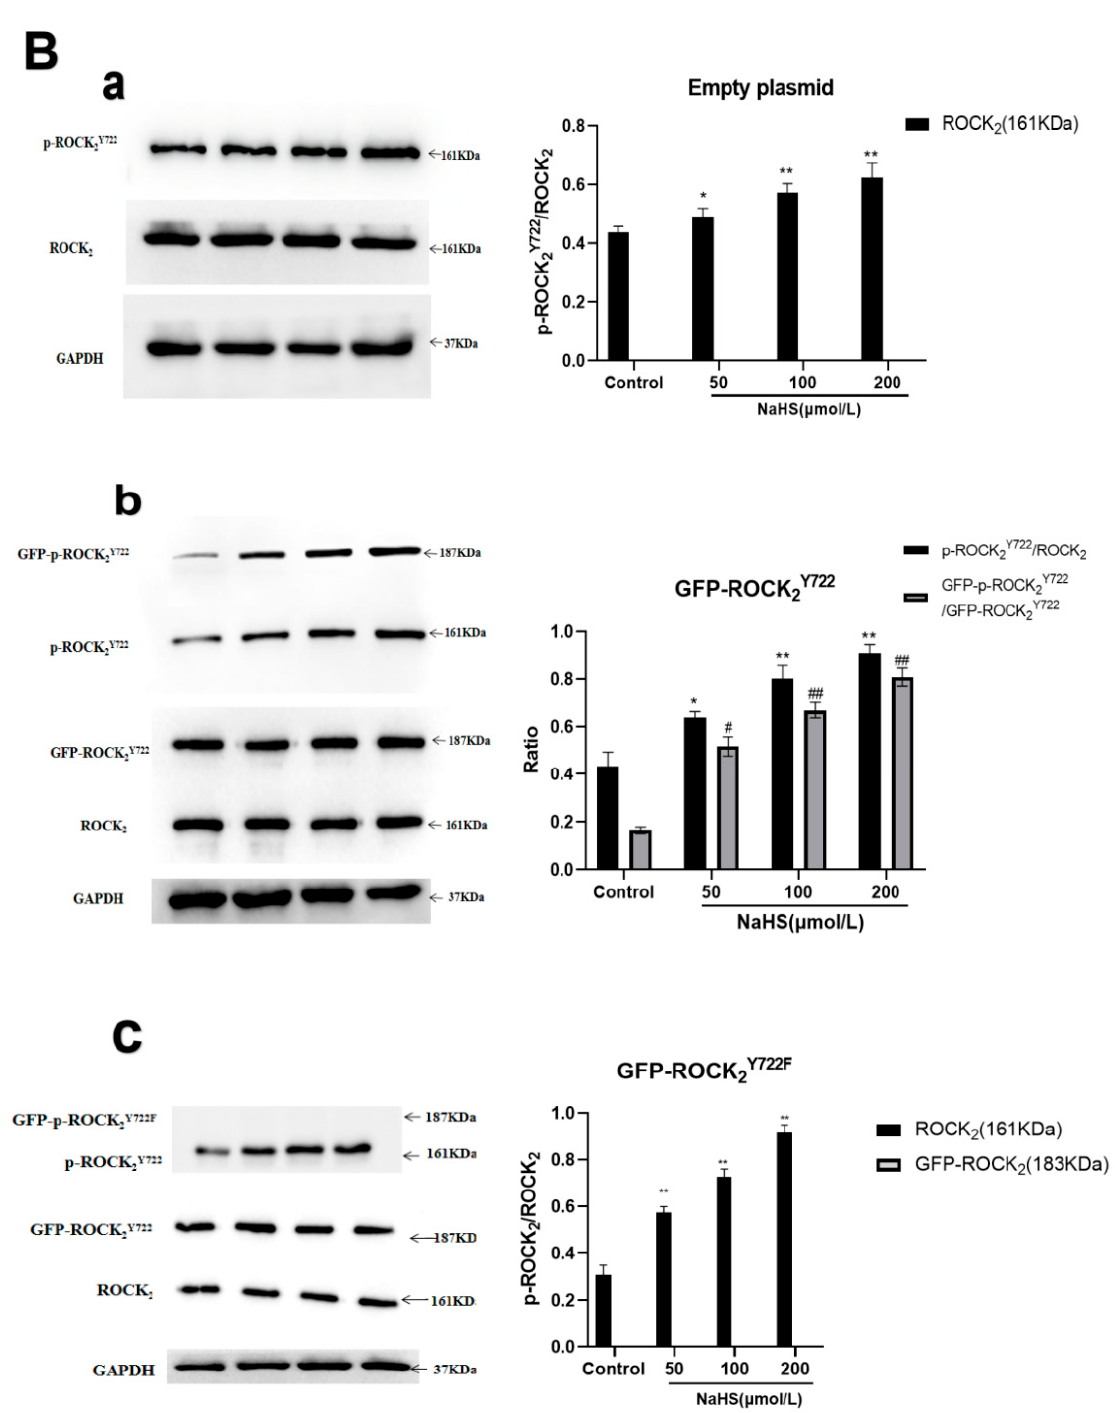
Figure 3. NaHS-induced phosphorylation of ROCK 2 or GFP-ROCK 2 at Tyr722 in the transfected RHNs. ( A ) Representative images of transfection. (( a ): Empty plasmid-transfected RHNs; ( b ): ROCK 2Y722 -pEGFP-N1 plasmid-transfected RHNs; ( c ): ROCK 2Y722F -pEGFP-N1 plasmid-transfected RHNs.) (GFP-tagged, 100 µ m). ( B ) NaHS-promoted phosphorylation of ROCK 2 at Tyr722 (( a ): empty plasmid; ( b ): GFP-ROCK 2 Y722 group; ( c ): GFP-ROCK 2 Y722F group) (Western blot assay, mean ± SEM, n = 3). * p < 0.05, ** p < 0.01 vs. control group (p-ROCK 2 Y722 /ROCK 2 ), # p < 0.05, ## p < 0.01 vs. control group (GFP-p-ROCK 2 Y722 /GFP-ROCK 2 Y722